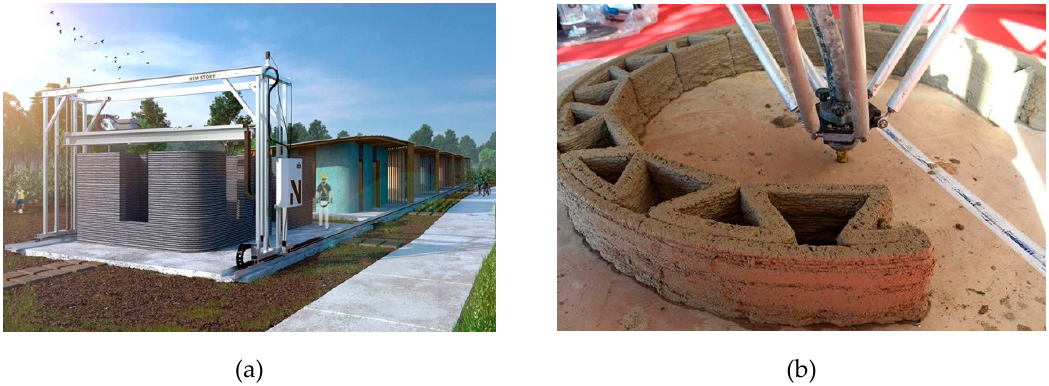
Figure 4. ( a ) ICON Vulcan II (Reproduced from [23]) and ( b ) WASP Crane apparatus (Reproduced from [24]).